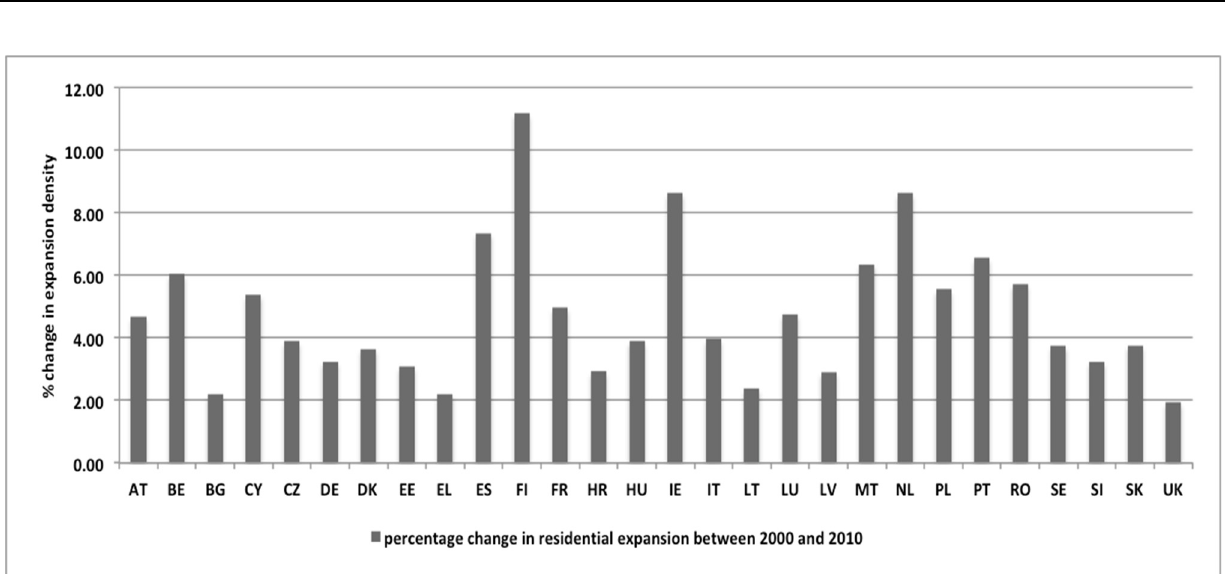
Figure 2. Percentage change in residential expansion densities between 2000 and 2010 in Europe.